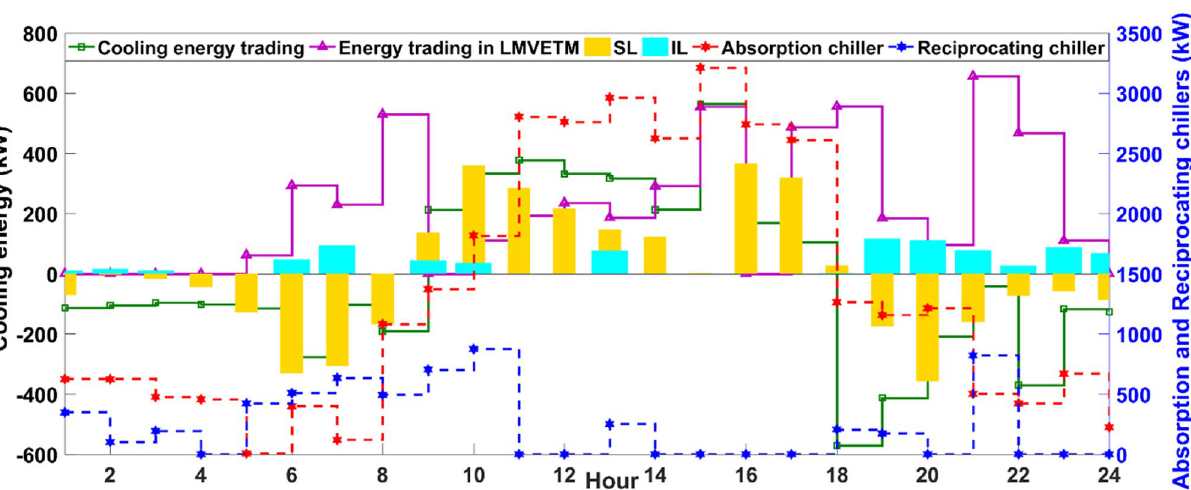
Figure 6. Optimal scheduling of the cooling energy units. It indicates the key role of cooling energy systems in enabling the integrated energy structure for sustainability and balancing multi-energy.